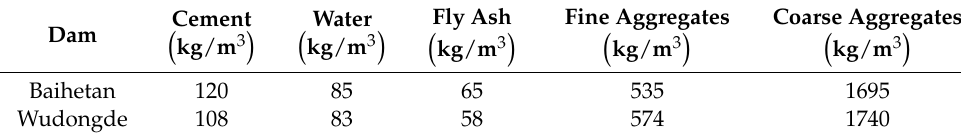
Table 1. Mixing proportions of the concrete.